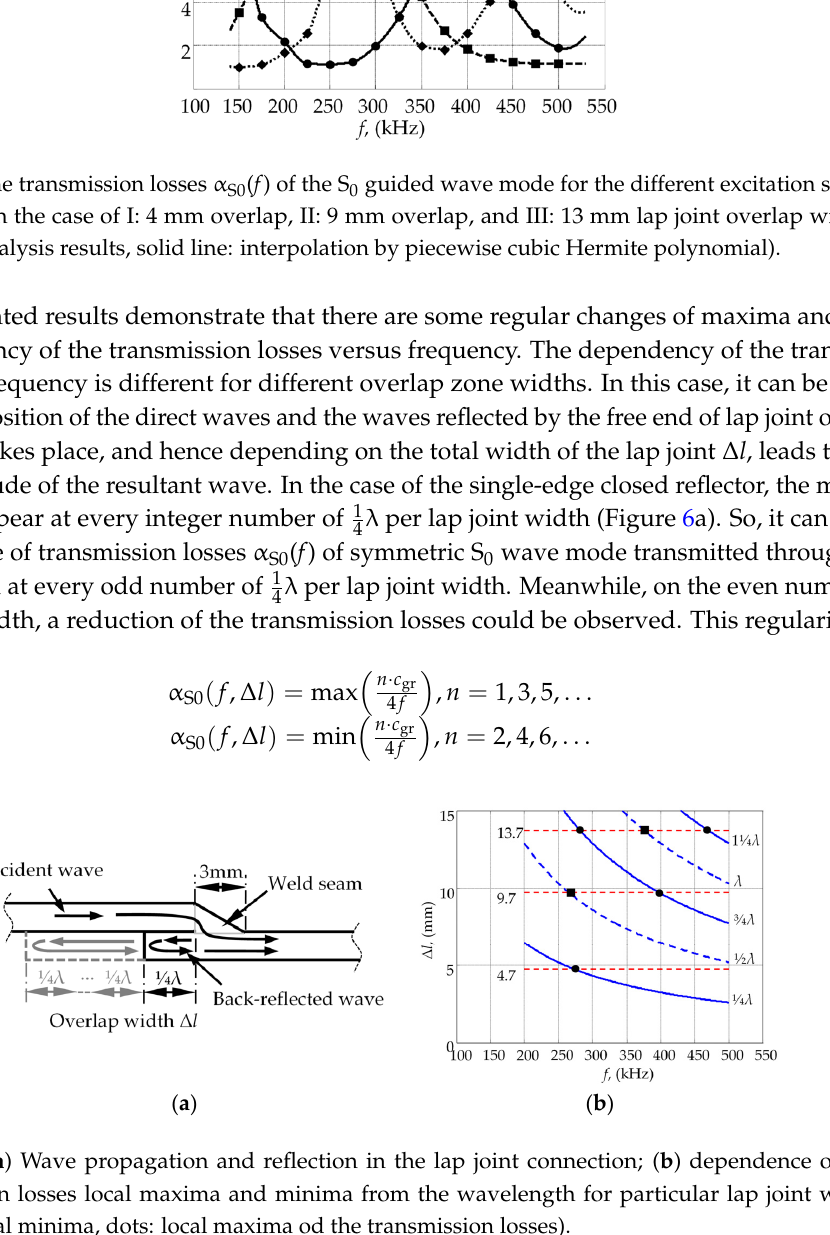
Figure 6. ( a ) Wave propagation and reflection in the lap joint connection; ( b ) dependence of the transmission losses local maxima and minima from the wavelength for particular lap joint width (square: local minima, dots: local maxima od the transmission losses).